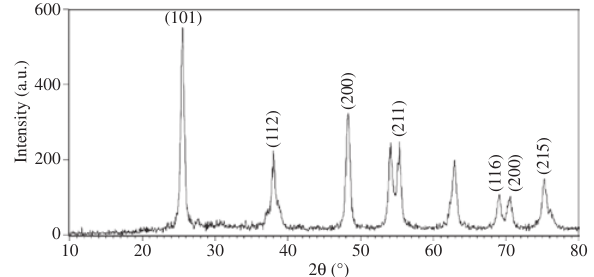
O nanoparticles prepared 12 19